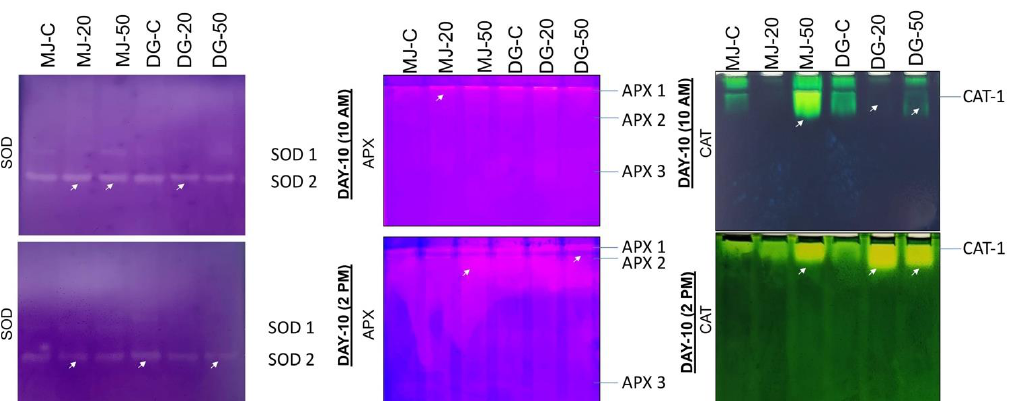
Figure 8. ( A ) SOD, ( B ) APX, and ( C ) catalase activity in spinach genotypes Delhi green (DG) and Malav Jyoti (MJ). Results are presented for controls (MJ control; DG control), 20 mM of NaCl treatments (MJ-20 mM; DG-20 mM), and 50 mM of NaCl treatments (MJ-50 mM; DG-50 mM). Sampling was performed (on the basis of the circadian cycle) at 4 h intervals corresponding to the exact times of 6 am, 10 am, 2 pm and 6 pm on both day 5 and day 10 of salinity stress. Vertical bars indicate th mean ± S.E. for n = 3. Means with different letters are significantly different at p ≤ 0.05 according to the Tukey’s studentized range test. Data for day 5 and day 10 are shown separately and the colors of the bars correspond to treatments, which remain the same for different hours.